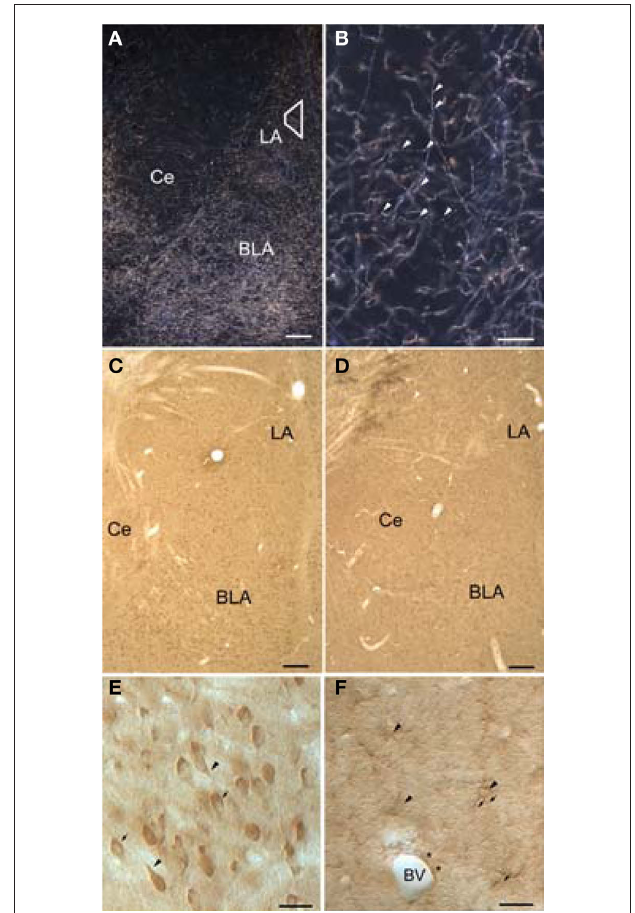
Figure 1 | Light micrographs showing dopamine beta-hydroxylase (D β H) and beta-adrenergic receptors ( β Ars) in the amygdala. (A) Dark- field micrograph shows D β H in the amygdala. Trapezoid corresponds to area examined by electron microscopy. (B) Higher-magnification dark-field micrograph illustrates thin, varicose D β H axons. Arrowheads point to varicosities. (C,D) Low-magnification bright-field micrographs show β AR 248 (C) , and β AR 404 (D) are distributed homogenously throughout the amygdala. (e) Higher magnification shows that β AR 248 intensely labels somata and some proximal dendrites (arrowheads). The nuclei of some labeled cells are seen in some cells (arrows) but are difficult to distinguish in others. (F) Higher-power Nomarski optics show labeled astrocytic cell bodies (arrowheads) and their radiating processes (arrows). Also shown is an astrocytic process (asterisks) surrounding a blood vessel (BV). Scale bar = 100 μm in A – D , 50 μm in B, e, and F . BLA, basolateral amygdala; Ce, central amygdala; LA, lateral